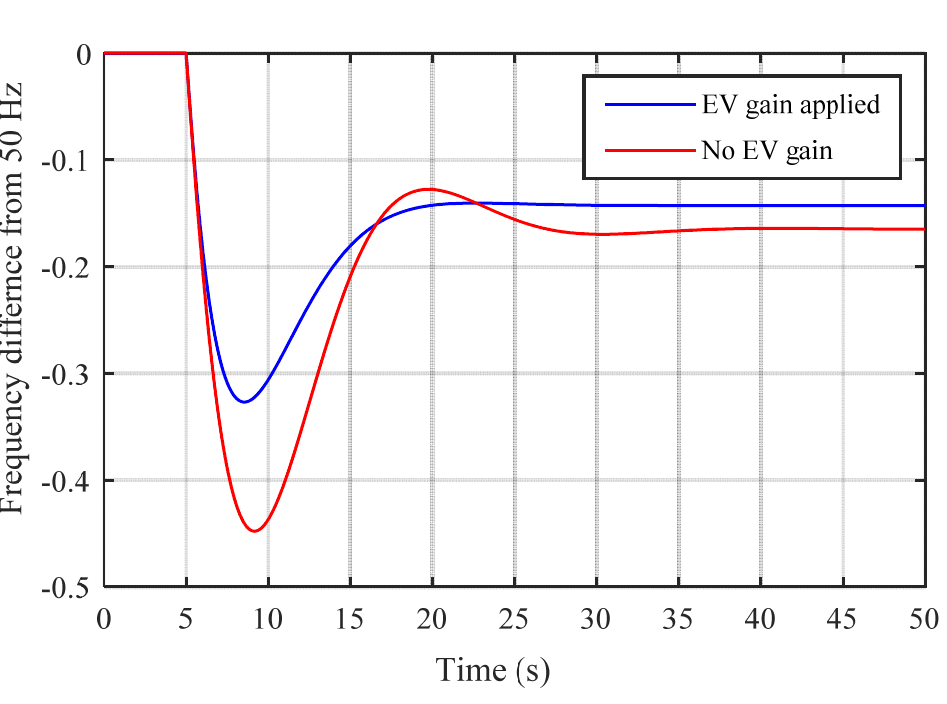
Figure A1. The primary frequency response of GB power system with and without the feedback gain of electrical vehicles.